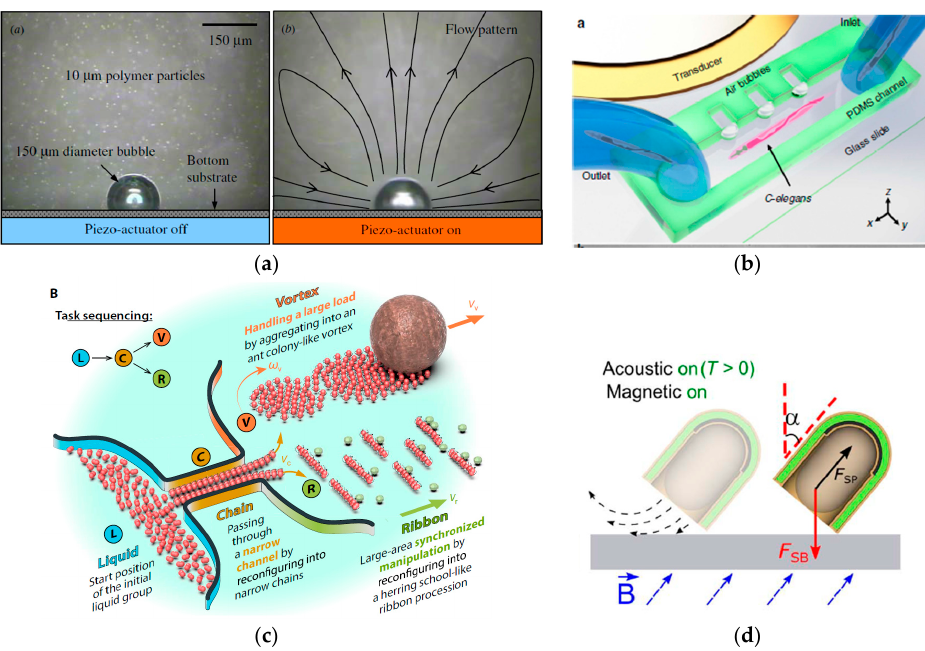
Figure 7. Vibrated microbubble and microrobot methods by Chung et al. [31] , Ahmed et al. [77,78] ,